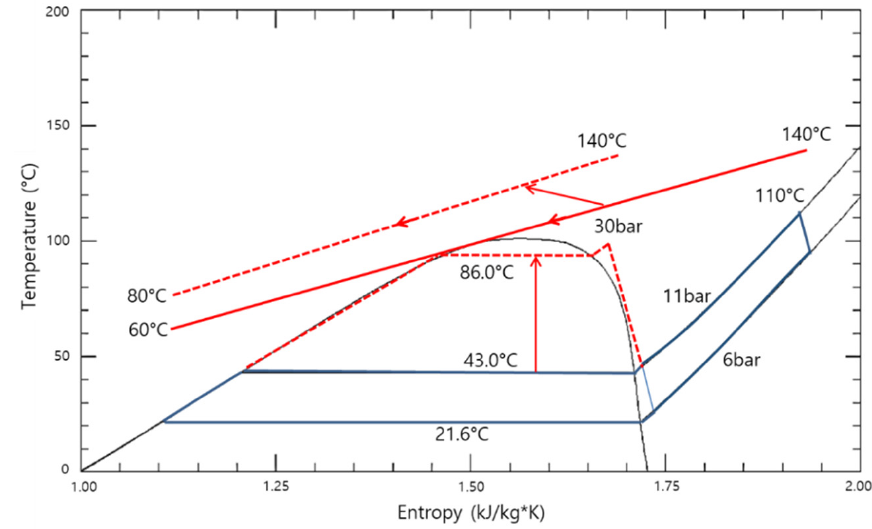
Figure 5. Improvement of thermal efficiency of the ORC unit. the capacity of the scroll expander (model: E15H022A-SH) built by Air Squared, Inc. is difficult to match the capacity of the scroll expander with the capacity of the burner in the laboratory. As a result, to increase the pressure on the high-pressure side, an additional working fluid (R134a) heated by the steam from the boiler to the same state as the working fluid from the waste heat recovery of the flue gas was added to the inlet of the expander. Despite the fact that the power of the expander was increased due to the additional heat input, the net power from the waste heat recovery of the flue gas was calculated using the portion of the working fluid that was allowed to pass into the expander.